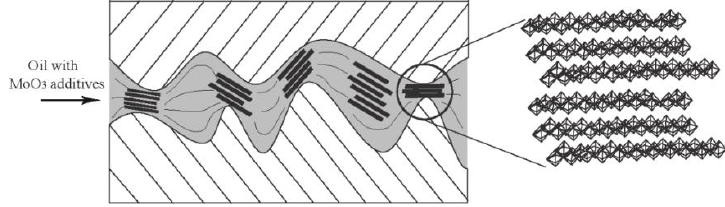
Figure 7. Schematic diagram of friction-reducing of micro-lamellar MoO 3 additives.